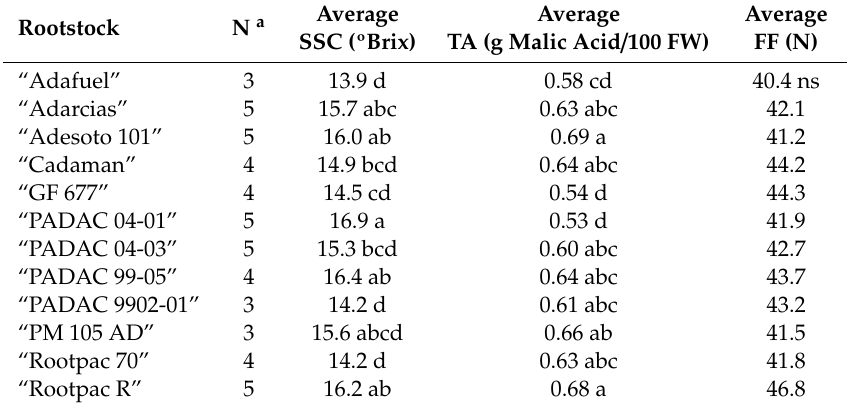
Table 6. Rootstock e ff ect on fruit quality parameters of “Big Top” fruits on twelve rootstocks during five years of study